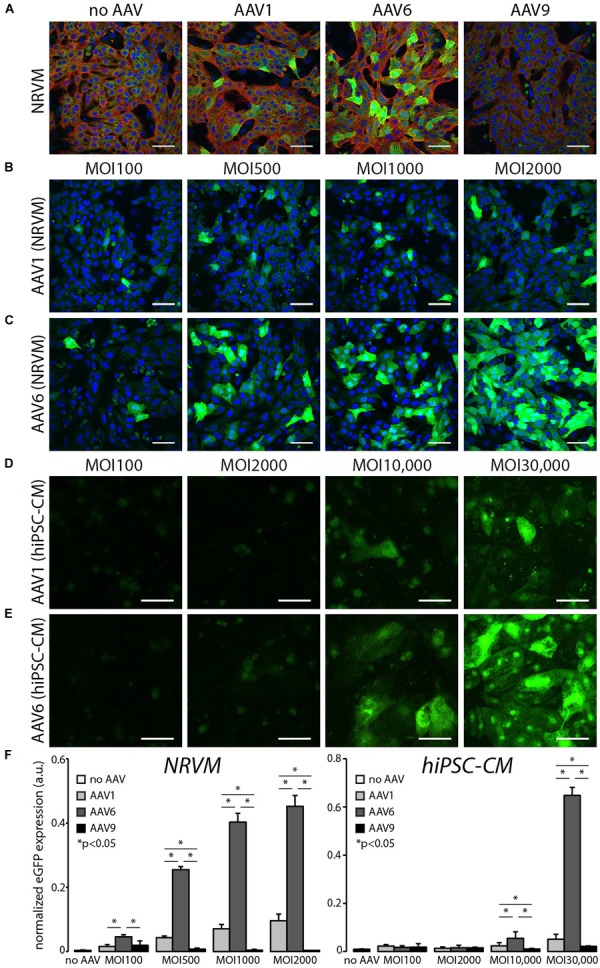
In vitro AAV6-mediated transgene expression is superior to the use of AAV1 and AAV9 in rat and human cardiomyocytes. (A) Cardiomyocyte-specific eGFP expression in NRVMs and hiPSC-CMs using AAV1, 6, and 9. AAV9-mediated expression did not exhibit levels of fluorescence above that of autofluorescence in non-infected control cells. Cell nuclei were labeled with DAPI (blue, NRVMS only), AAV-infected cells expressed eGFP (green), and cardiomyocytes were labeled with α-actinin (red); MOI 1000. (B,D) AAV1-mediated and (C,E) AAV6-mediated eGFP expression at four viral doses 5 days post-infection. hiPSC-CMs required viral doses two orders of magnitude greater than NRVMs (MOI 10,000 versus MOI 100) to show threshold eGFP expression. All scale bars are 50 μm and color-enhanced images are shown. (F) Quantification of the dose-dependent increase in eGFP expression in NRVMs and hiPSC-CMs. AAV6-mediated eGFP expression was significantly higher than AAV1-mediated expression at all viral doses. Data are presented as mean ± SEM (n = 3–7 independent samples per group). ∗Significance level at p < 0.05.